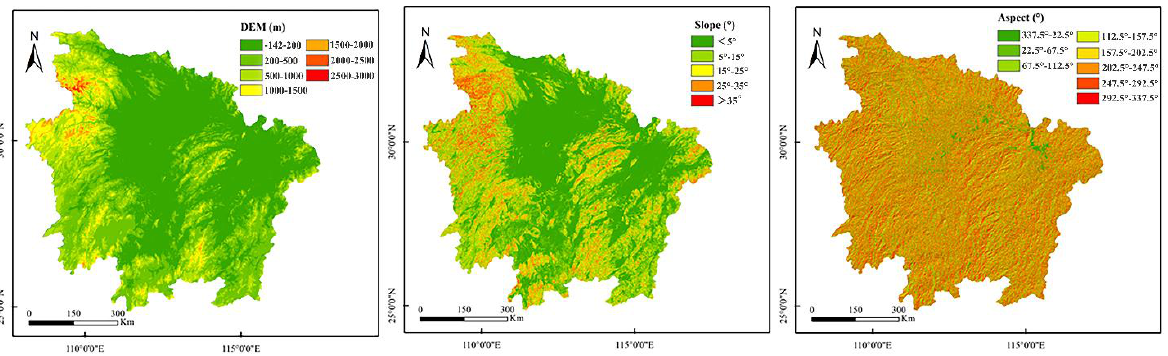
Figure 5. Elevation map of the middle reaches of the Yangtze River (MRYR). Table 6. Annual average NDVI changes at different altitudes in the middle reaches of the Yangtze River (MRYR).